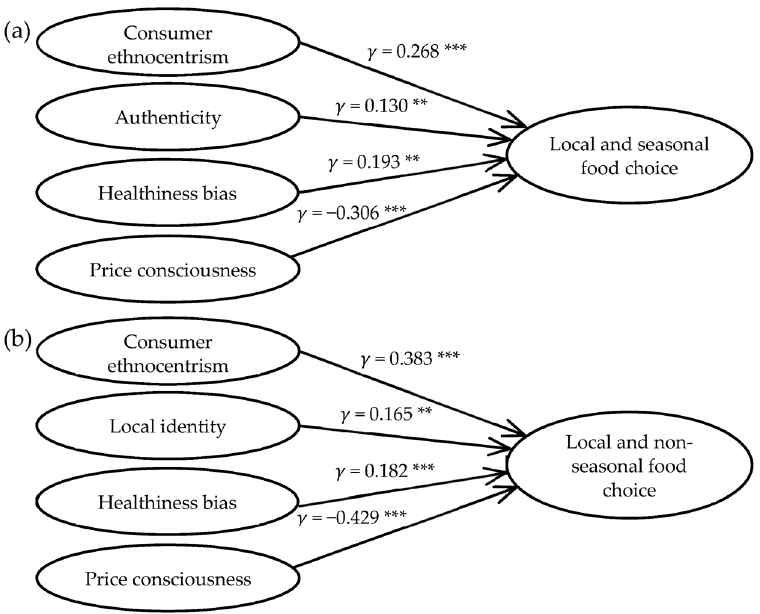
Figure 2. Evaluated research model including significant relationships between three motives and one barrier on ( a ) local and seasonal food choice and ( b ) local and non-seasonal food choice; ** p < 0.05, *** p <